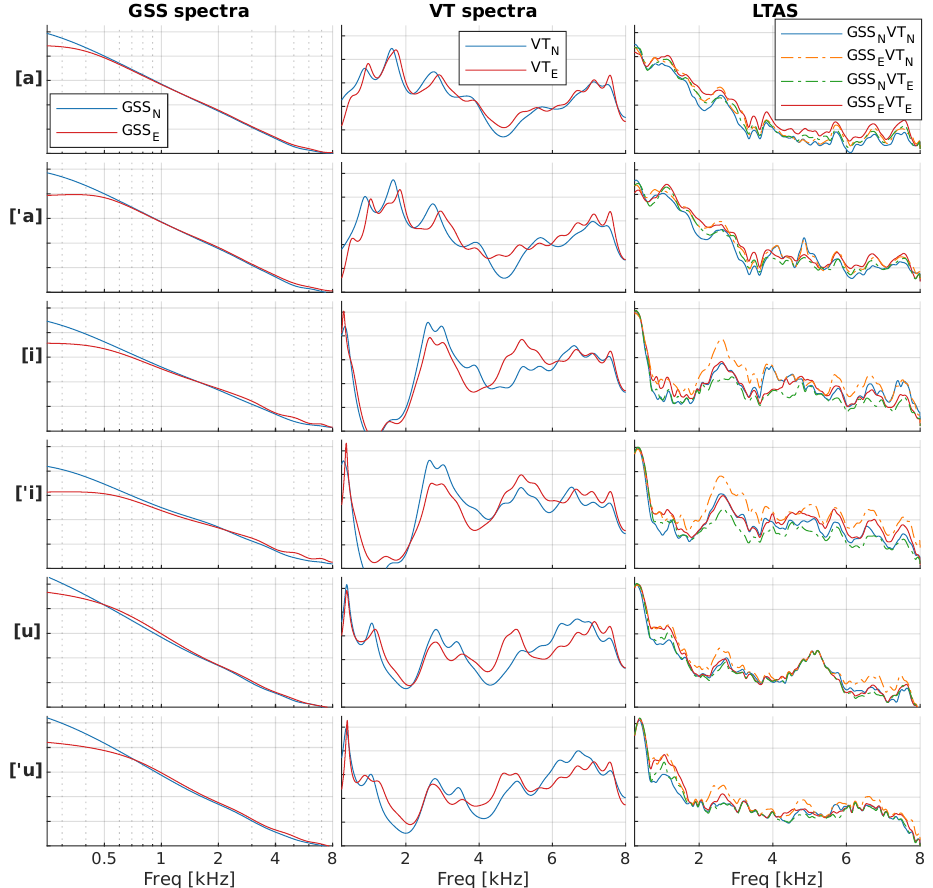
Figure 6. Averaged spectra of the analysed configurations for the happy emotion. The first and the second column show the spectra obtained from the mean vectors of glottal source spectra and vocal tract, respectively, for the neutral (GSS N , VT N ) and expressive (GSS E , VT E ) configurations. The third column depicts the mean LTAS of the samples synthesised with the considered combinations of GSS and